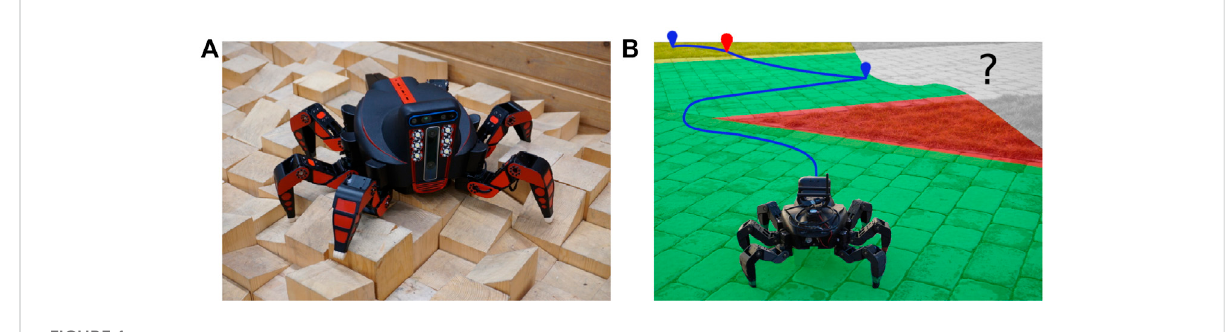
FIGURE 1 (A) Hexapodwalkingrobot(courtesyofForouharetal.(2021)) (B) anditsdeploymentusingtheproposedapproach.Thevisualizedplannedpath isto visitdeterminedexplorationgoalsforthespatial (inblue)andtraversal costmodels(inred).Thespatial explorationgoalsarelocated closetothe boundary of the already explored part of the environment. The traversal cost exploration goals correspond to sites where the terrain traversal cost model can be improved. Since the cost model is already partially learned, the red-tinted turf is known to be hard to traverse, and thus the robot prefersthegreen-tintedpavement,whichisrelativelyeasytotraverse.Theyellow-tintedterrainisyettobeexperiencedbytherobotandthuscarries the terrain learning goal indicated by the red waypoint. The not-yet-observed area is